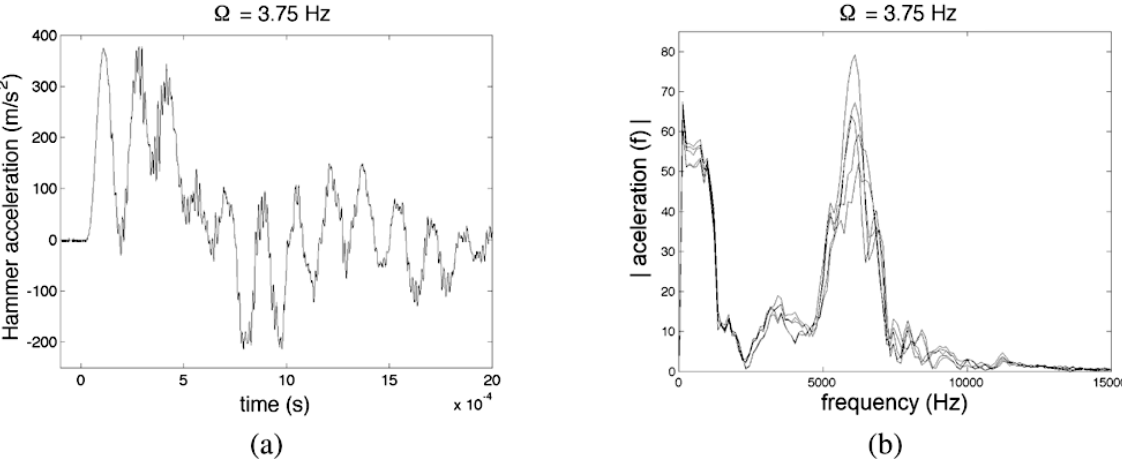
Fig. 5. a) Gap 0.0 mm, excitation frequency 3.75 Hz: Hammer acceleration during impact; b) FFT of hammer acceleration signal after several